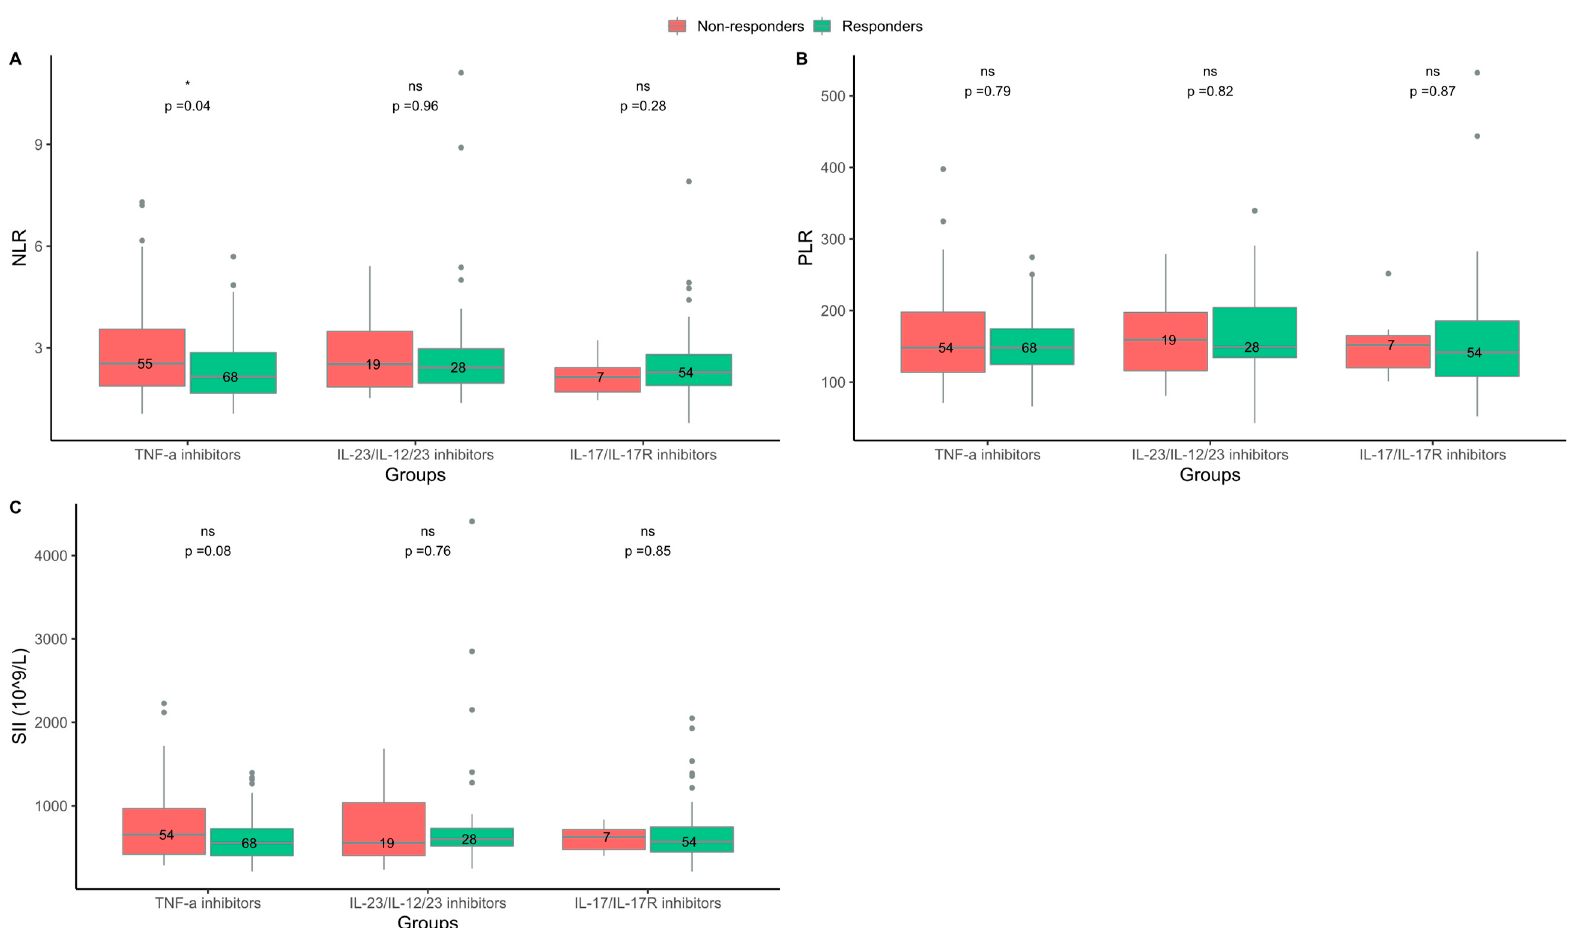
Figure 1. Blood cell biomarkers at baseline in responders and non-responders treated with either tumor necrosis factor (TNF)- α inhibitors, interleukin (IL)-23/IL- 12/23 inhibitors, or IL-17/IL-17R inhibitors. ( A ) Neutrophil-to-lymphocyte ratio (NLR). ( B ) Platelet-to-lymphocyte ratio (PLR). ( C ) Systemic immune–inflammation index (SII). Responders = psoriasis area and severity index (PASI) ≤ 2 three months after treatment start. Non-responders = PASI > 2 three months after treatment start. ns = non-signi fi cant. * p < 0.05.